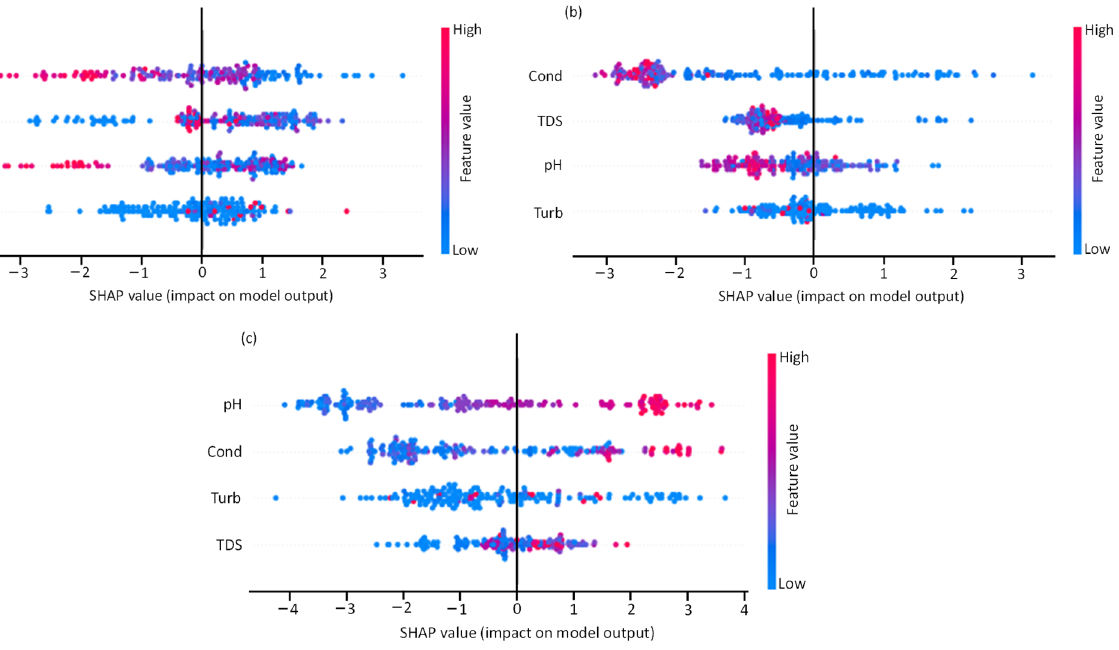
Figure 8. SHAP summary plot for different As concentrations: ( a ) low; ( b ) medium; and ( c ) high.